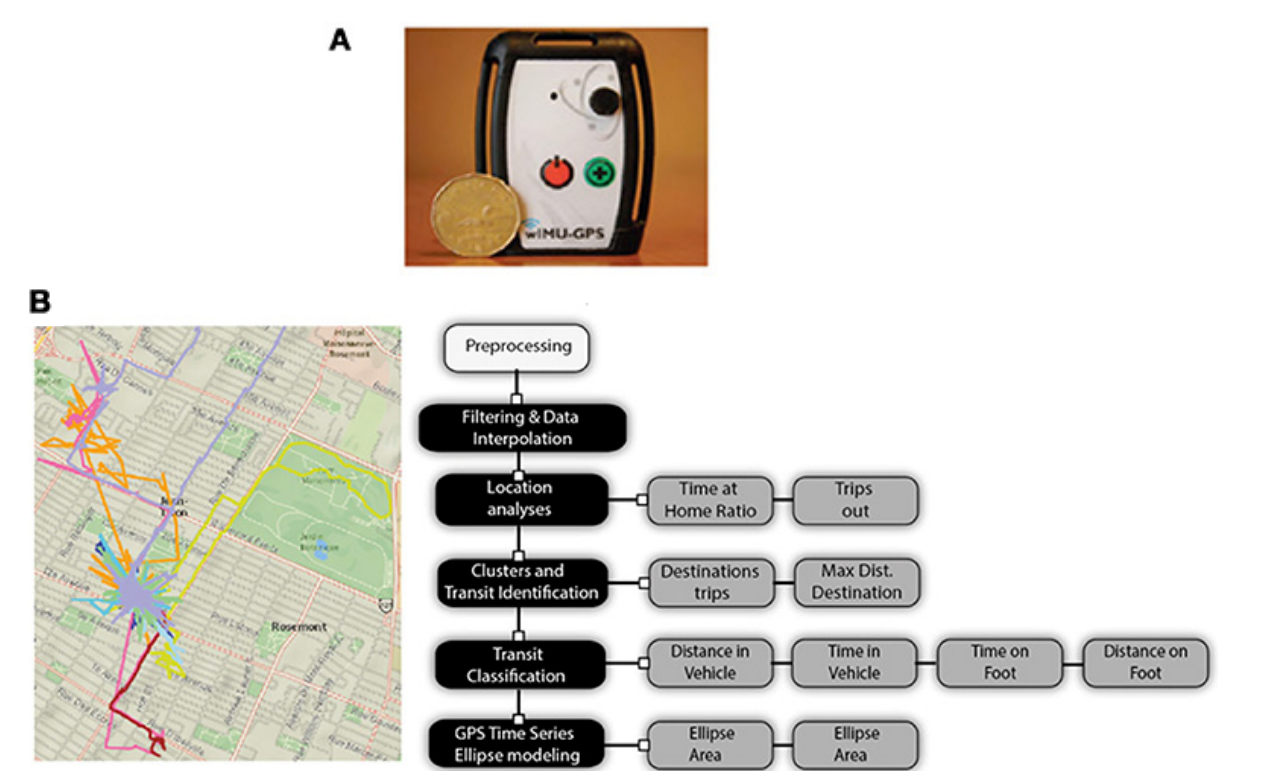
Figure 1. ( A ). Wireless inertial unit with GPS (WIMU-GPS). ( B ). Raw signals and signal processing steps and analysis of GPS signals (previously published in [14]).